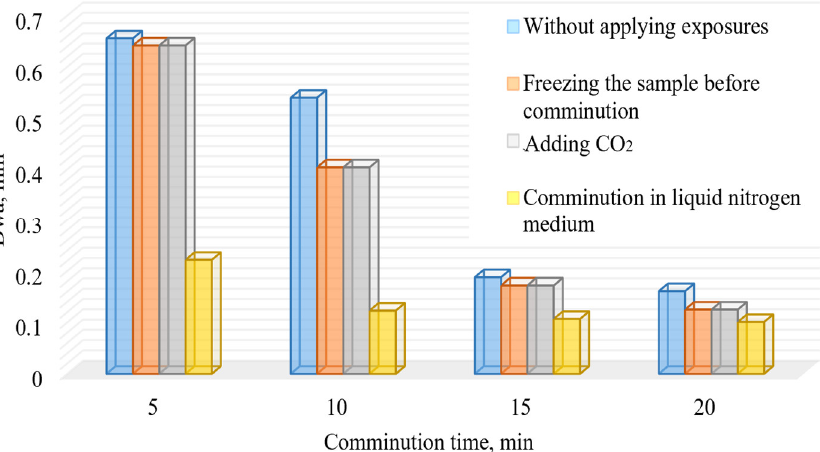
Figure 7. Dependence of the weighted average diameter of the comminution products of the DOS samples on the comminution time with and without using cryogenic